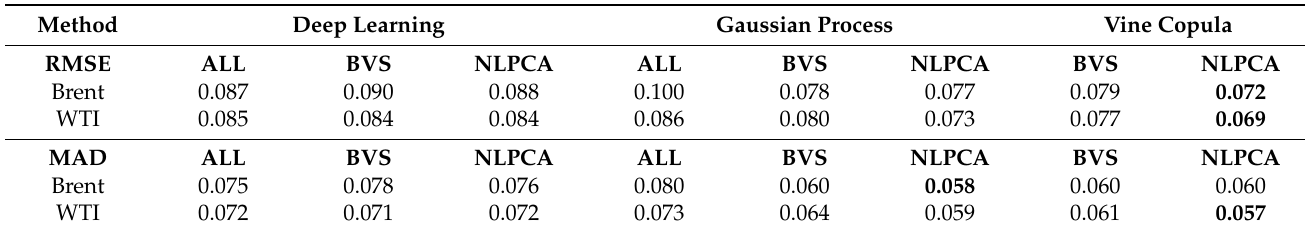
Table 6. RMSE and MAD for forecasting BRENT and WTI log return prices.